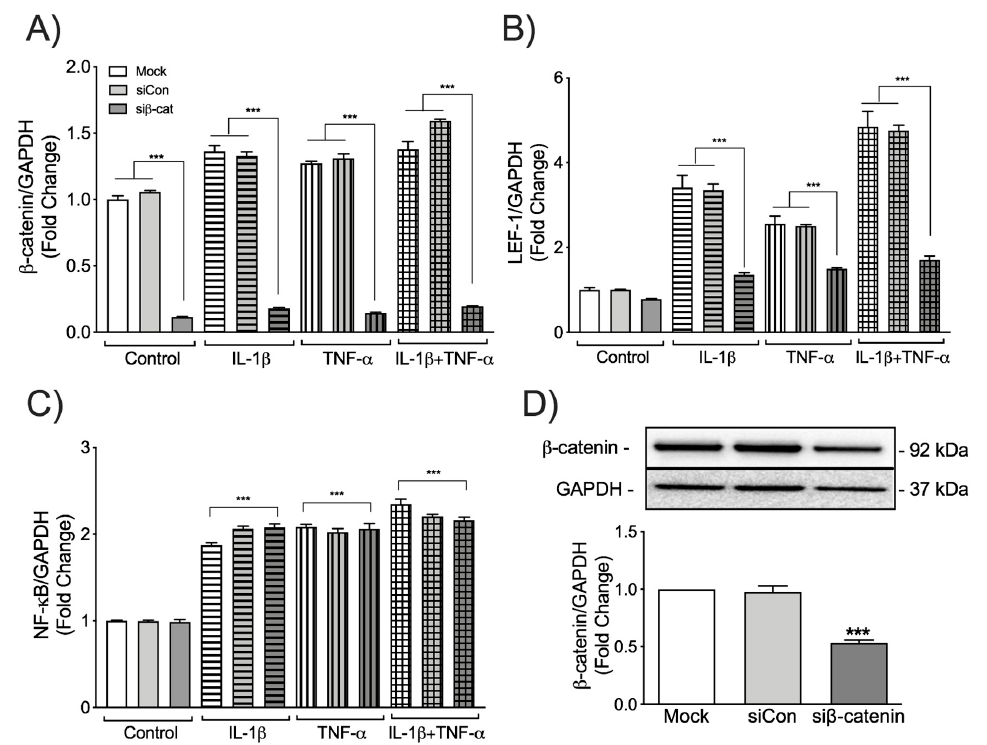
Figure 2. The effects of β -catenin knockdown on LEF-1 and NF- κ B induction in activated human astrocytes. Astrocytes were transfected with either no siRNA (Mock, white bars), non-targeting siRNA (siCon, light grey bars) or siRNA specific for β -catenin (si β -cat, dark grey bars). Astrocytes were then treated with the HIV-associated neurocognitive disorders (HAND)-relevant cytokines IL- 1 β (20 ng/mL, horizontal pattern) and TNF- α (50 ng/mL, vertical pattern), alone or in combination (graph check pattern). Total RNA was isolated 8 h post-treatment. ( A ) β -catenin, ( B ) LEF-1 and ( C ) NF- κ B mRNA levels were determined by RT-PCR. Data display mRNA fold changes compared to untreated controls. GAPDH was used as a normalizing control. Data are cumulative from three individual astrocyte donors. Statistical analyses were performed using one-way ANOVA with Tukey’s post-hoc test for multiple comparisons (*** p < 0.001 when compared to Mock or siCon within the treatment). Total protein was isolated 24 h post-treatment and ( D ) probed for β -catenin. β -catenin levels were quantified by densitometry. GAPDH was used as a loading control. Quantification represents cumulative data from three individual astrocyte donors (*** p < 0.001 when the treatment was compared to Mock or siCon). 3.3. β -Catenin Regulates Wound Healing and Astrocyte Proliferation Wnt/ β -catenin canonical pathway regulates cell proliferation, cell mobility and differentiation. To investigate the role of β -catenin signaling in astrocyte proliferation and migration following injury, either no siRNA (Mock), non-targeting siRNA (siCon) or siRNA specific for β -catenin (si β - catenin) transfected astrocytes were plated, and a scratch was made following recovery. Wound sites were observed at defined time points to measure astrocyte migration. No difference in astrocyte migration was seen at 8 h in all conditions (Figure 3A1, B1, C1). However, β -catenin knockdown significantly reduced the migration of astrocytes to the injury site at 24 and 36 h (Figure 3C2 and C3, respectively) compared to mock and siCon transfected astrocytes (Figure 3A2, B2 and A3, B3, respectively). Scratched monolayers were completely closed after 48 h in both mock and siCon transfected astrocytes (Figure 3A4 and B4, respectively), leaving minor gaps in the wound of si β - catenin transfected astrocytes (Figure 3C4).